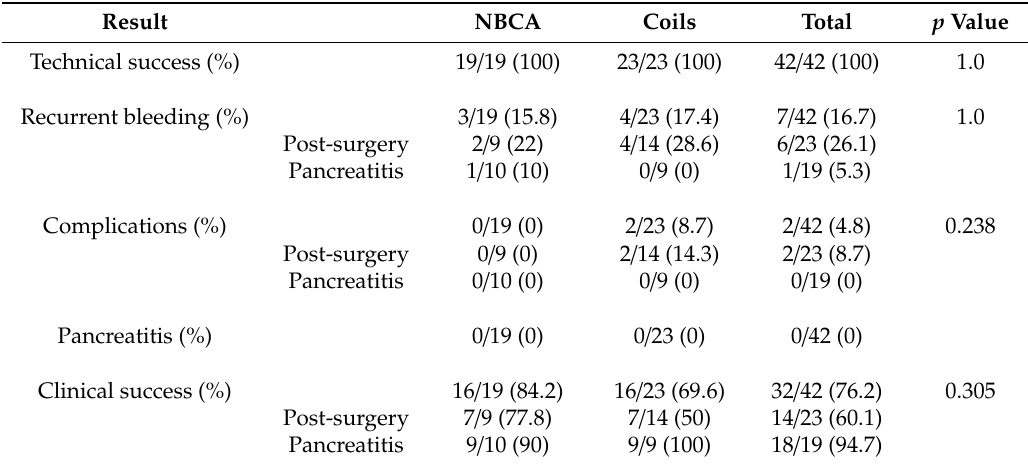
Table 2. Summary of